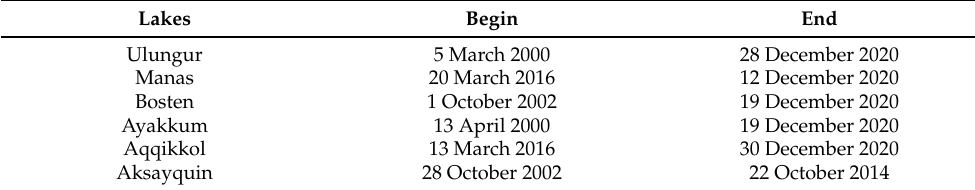
Table 2. The temporal span of observational water level data for six lakes. Lakes Begin End